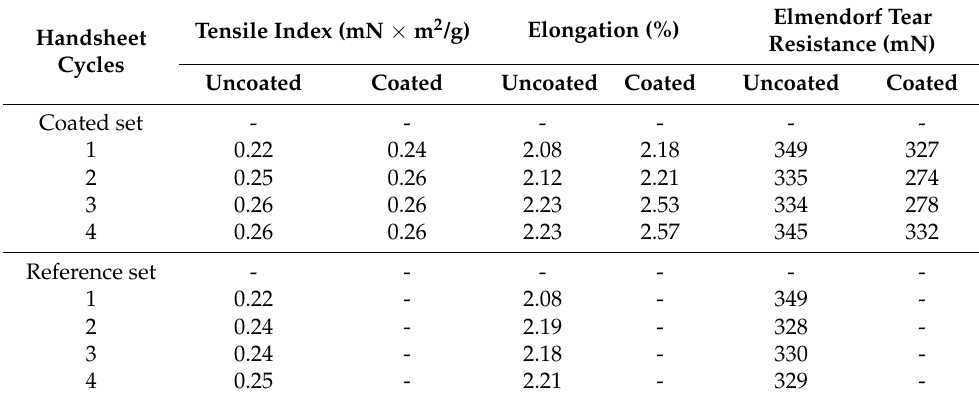
Table 5. Mechanical properties of handsheets prepared in recycling